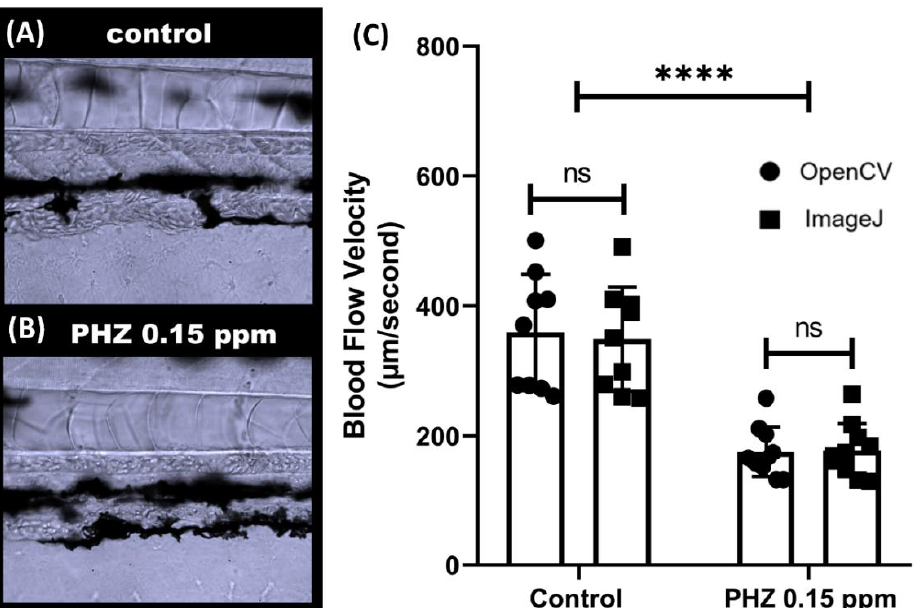
Figure 5. Validation of OpenBloodFlow method through comparison with ImageJ performance for blood flow velocity measurement in zebrafish larvae after exposure to control ( A ) and 0.15 ppm PHZ (Phenylhydrazine) ( B ). PHZ exposure significantly reduced the blood flow velocity in zebrafish larvae. ( C ) Side-by-side comparison of the average blood flow velocity measurement by ImageJ and OpenCV methods. The data were presented as mean with standard deviation, and statistical significance was determined by paired t -test for intra-group comparison or unpaired t -test for inter-group comparison. (ns = no significance, **** p < 0.0001, n = 10) (circle dots show the data analyzed by OpenCV, while square dots show the data analyzed by ImageJ).